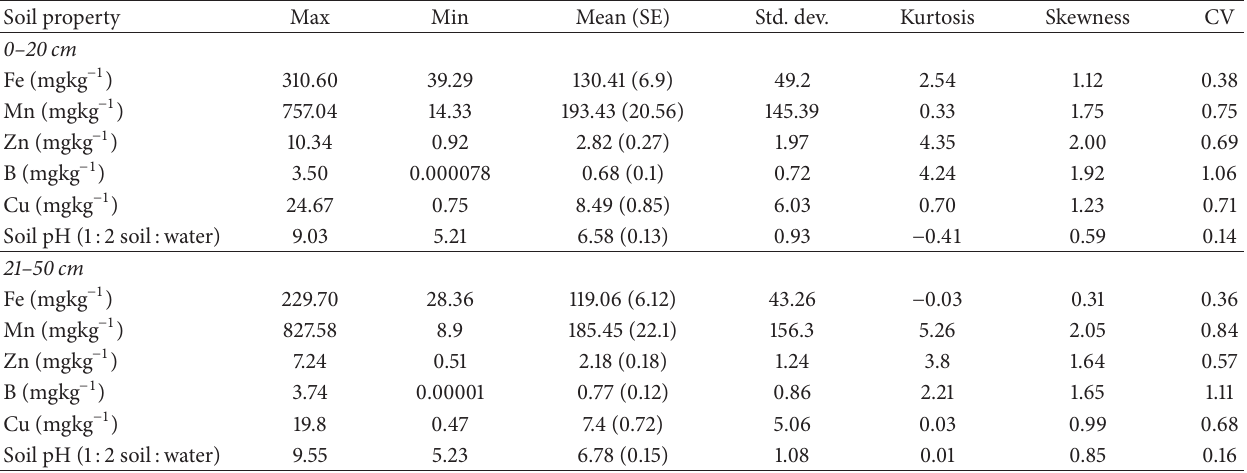
Table 2: Descriptive statistics for the soil micronutrients on the southern slopes Mount Kilimanjaro, Tanzania. Soil property